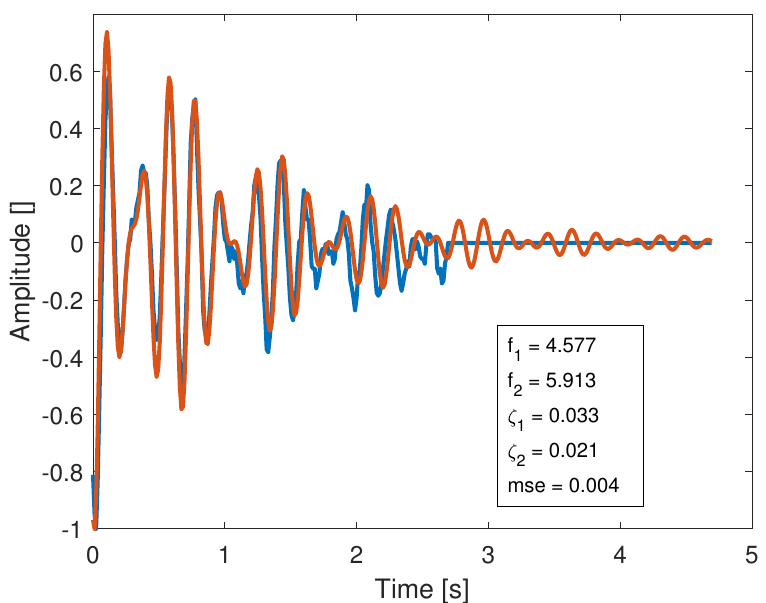
Figure 17. Original signal (blue) and signal reconstruction processed by the PRESTO technique (red). MSE order 10 (lower order means better